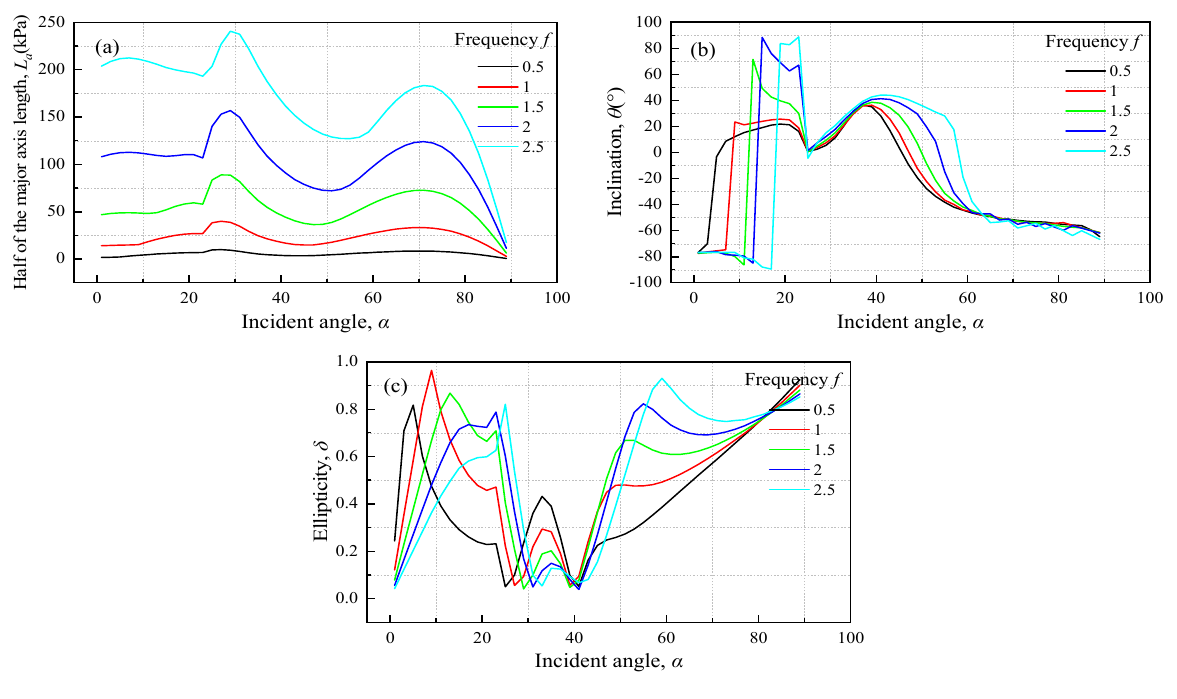
Figure 7. Variation of characteristic parameters of elliptical stress path with the incidence angle for various frequencies.